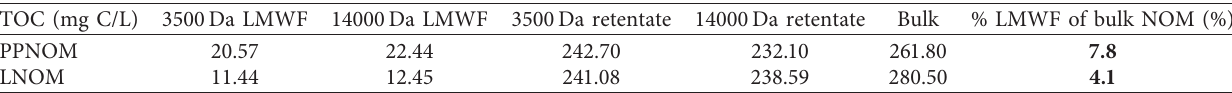
Table 1: TOC contents (mg C/L) of different molecular weight fractions (including LMWF, retentate and bulk LNOM, and PPNOM, respectively) at the end of dialysis